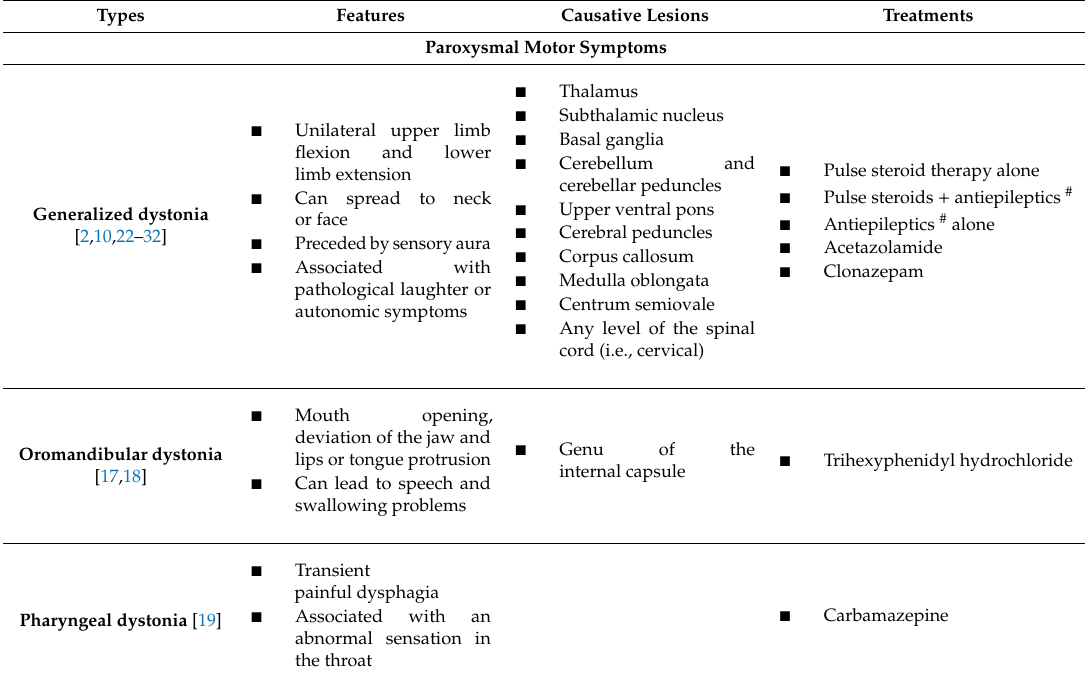
Table A1. Summary of paroxysmal symptoms features, causative lesions and treatment